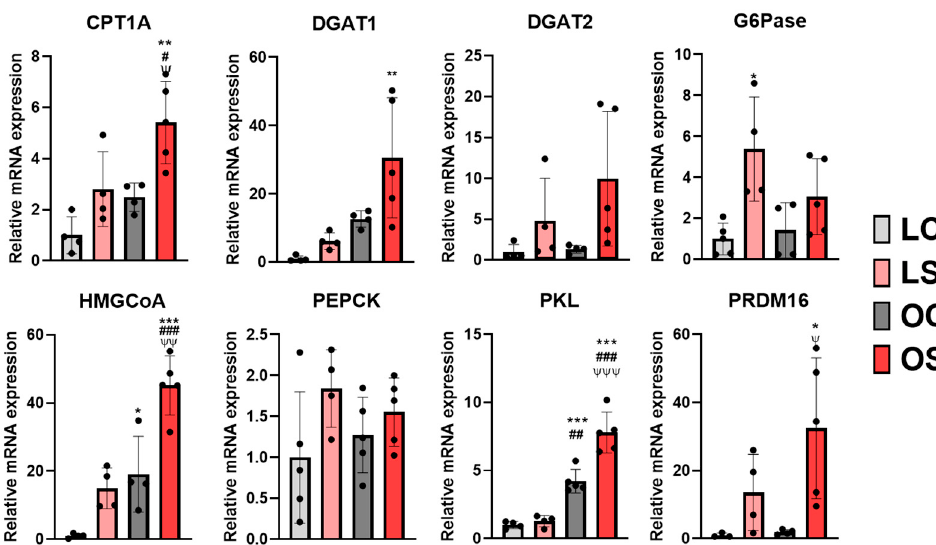
Figure 4. Gene expression in the liver of glucose, lipid, and ketogenic metabolism. LC, lean control; LS, lean supplemented with sofrito ; OC, obese control; OS, obese supplemented with sofrito . * p < 0.05, ** p < 0.01, *** p < 0.001 vs. LC; # p < 0.05, ## p < 0.01, ### p < 0.001 vs. LS; ψ p < 0.05, ψψ p < 0.01, ψψψ p < 0.001 vs. OC. CPT1A, carnitine palmitoyltransferase 1A; DGAT1, diacylglycerol O-acyltransferase 1; DGAT2, diacylglycerol O-acyltransferase 2; G6Pase, glucose 6-phosphatase; HMGCoA,